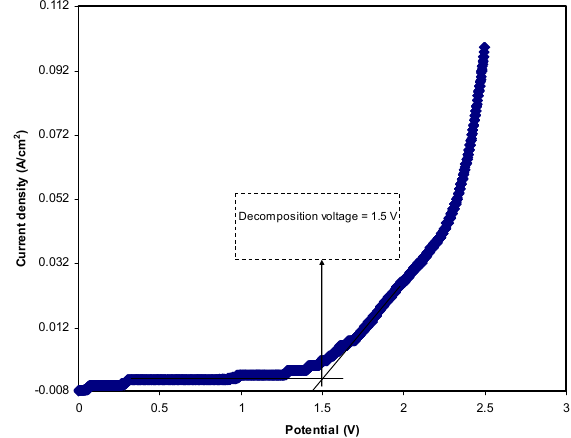
Figure 5. LSV plot of the highest conducting plasticized system at 20 mV/s.